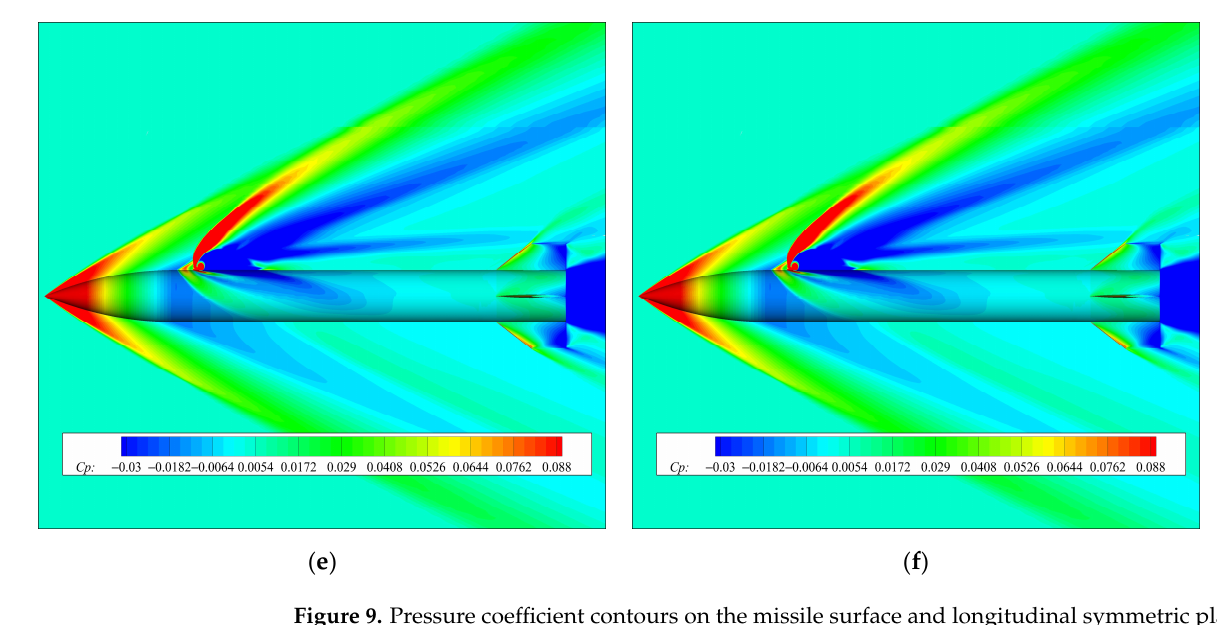
Figure 9. Pressure coefficient contours on the missile surface and longitudinal symmetric plane at different times since lateral jet startup: ( a ) t = 0.05 ms; ( b ) t = 0.1 ms; ( c ) t = 0.2 ms; ( d ) t = 0.5 ms; ( e ) t = 1 ms; ( f ) t = 2.4 ms.